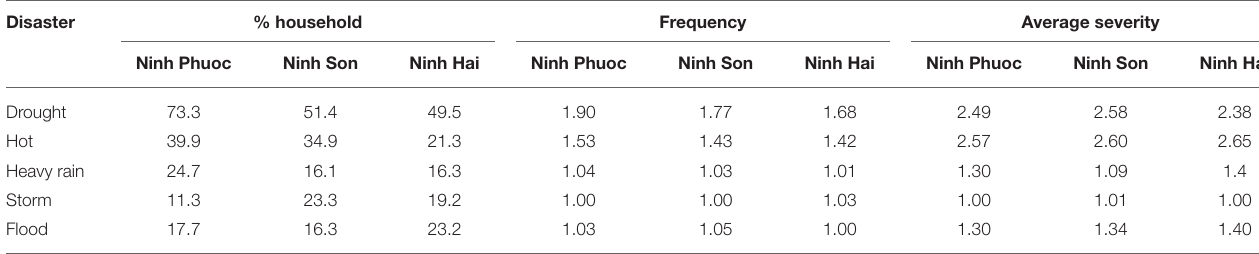
TABLE 4 | Awareness of natural disasters by farmers in Ninh Thuan. Disaster % household Frequency